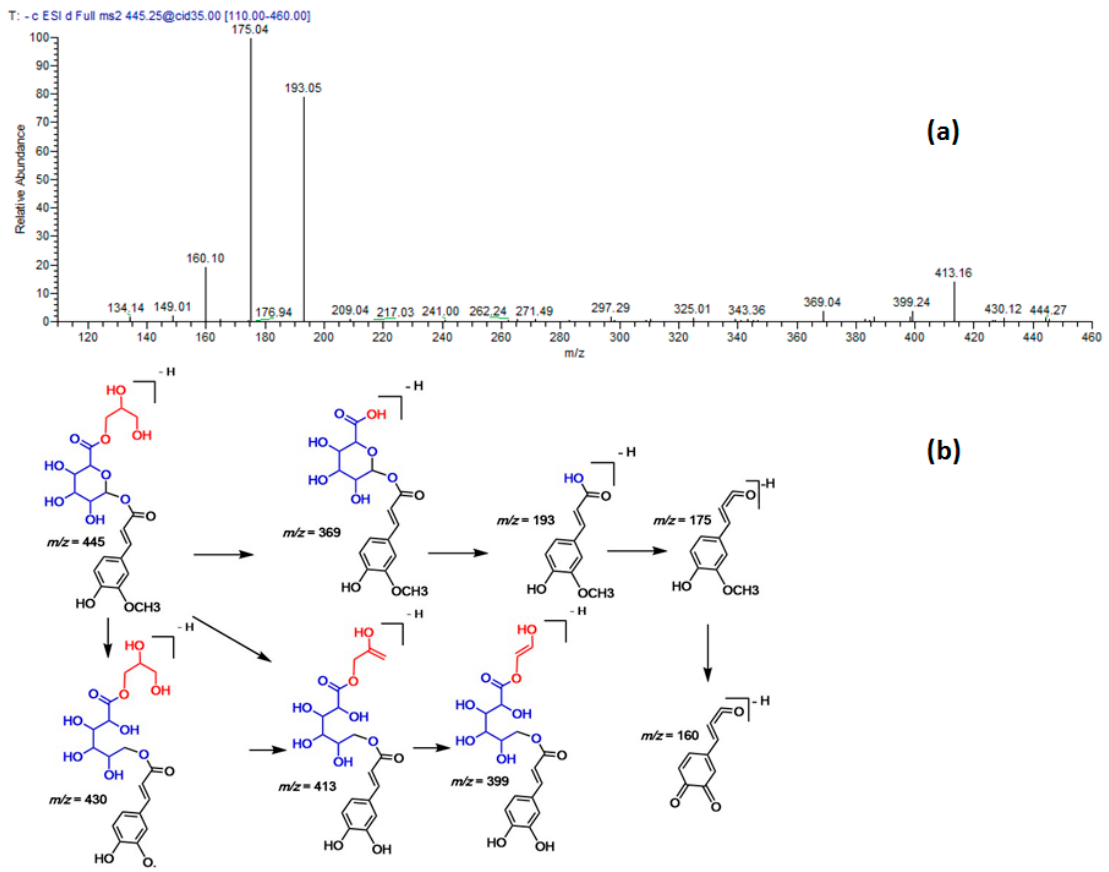
Figure 4. ( a ) MS/MS spectra of ferulyl O -glyceryl glucuronic acid at [M – H] − m/z 445. ( b ) A postulated fragmentation pattern in the negative ion mode.